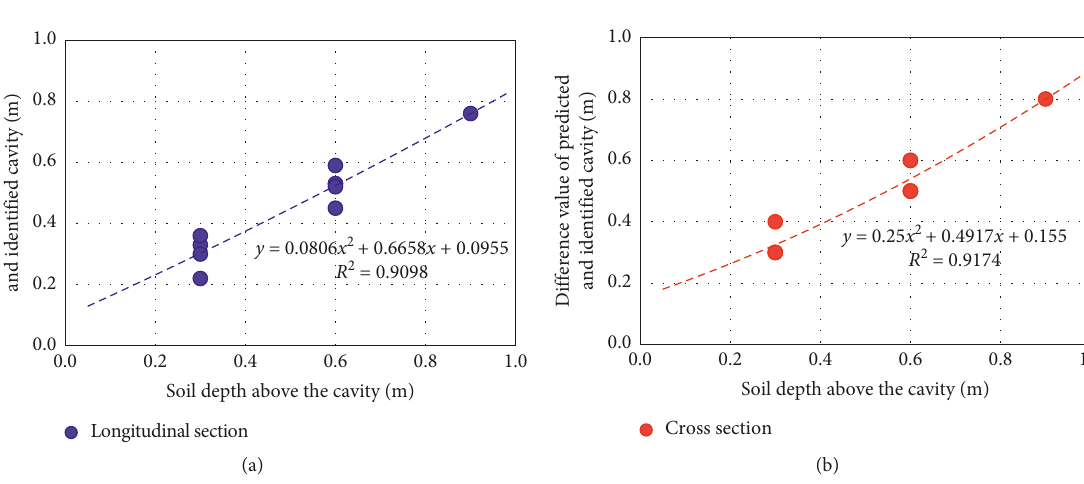
Figure 13: Correlation of the cavity scale according to the soil depth. (a) Longitudinal section. (b) Cross section.